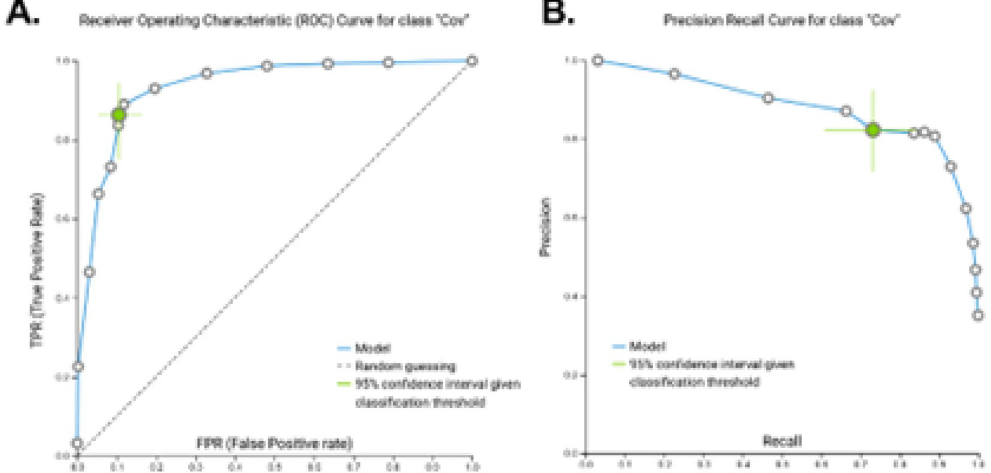
Figure 2. Model performance (training). Receiver-operating characteristic (ROC) and Precision-Recall curves (PRC) for the performance of the artificial intelligence-based classification model to identify patients with severe COVID-19 disease in the training (GSE167202) cohort. AUC area under the curve; “Cov” COVID-19 disease classification. Colored circle represents the optimized classification threshold to predict COVID-19 disease, while bars extending from the circle represent 95% confidence. ( A,B ) ROC (AUC = 0.933 [0.855, 0.970]) and PRC (AUC = 0.965 [0.932, 0.986]) for model training